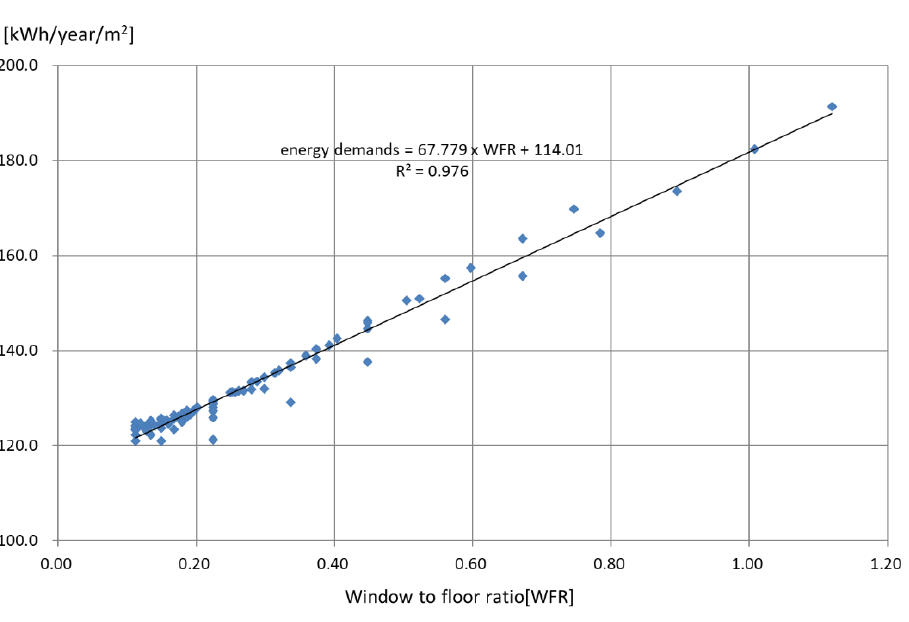
Energies 2021 , 14 , x FOR PEER REVIEW Figure 3. Energy demands per area according to the WFR. Figure 3. Energy demands per area according to the WFR.